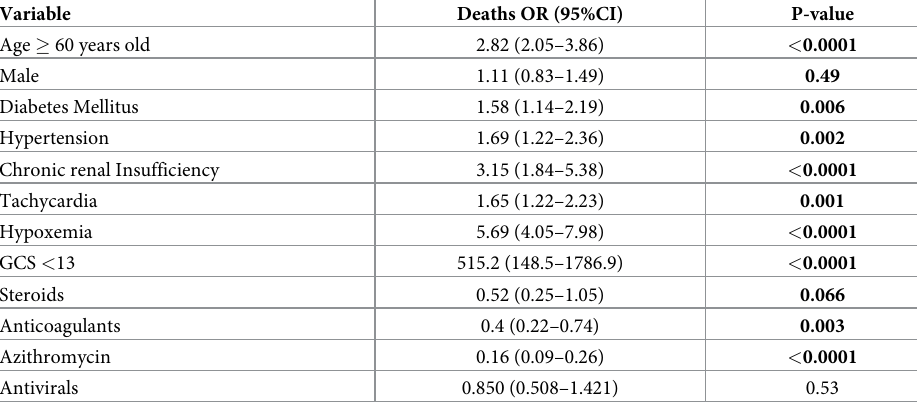
Table 4. Generalized linear nodels for risk predictors of COVID-19 mortality.